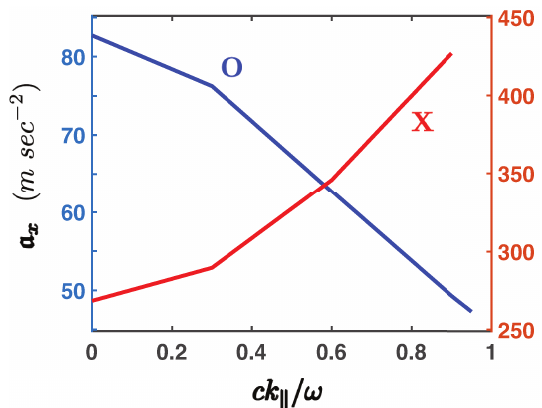
Figure 8. The acceleration of a filament induced by the radiation force of the O mode (left scale) and the X mode (right scale) as function of ck (cid:107) /ω . The density inside the filament is less than the background density. The positive acceleration means that the filament is being pushed away from the RF